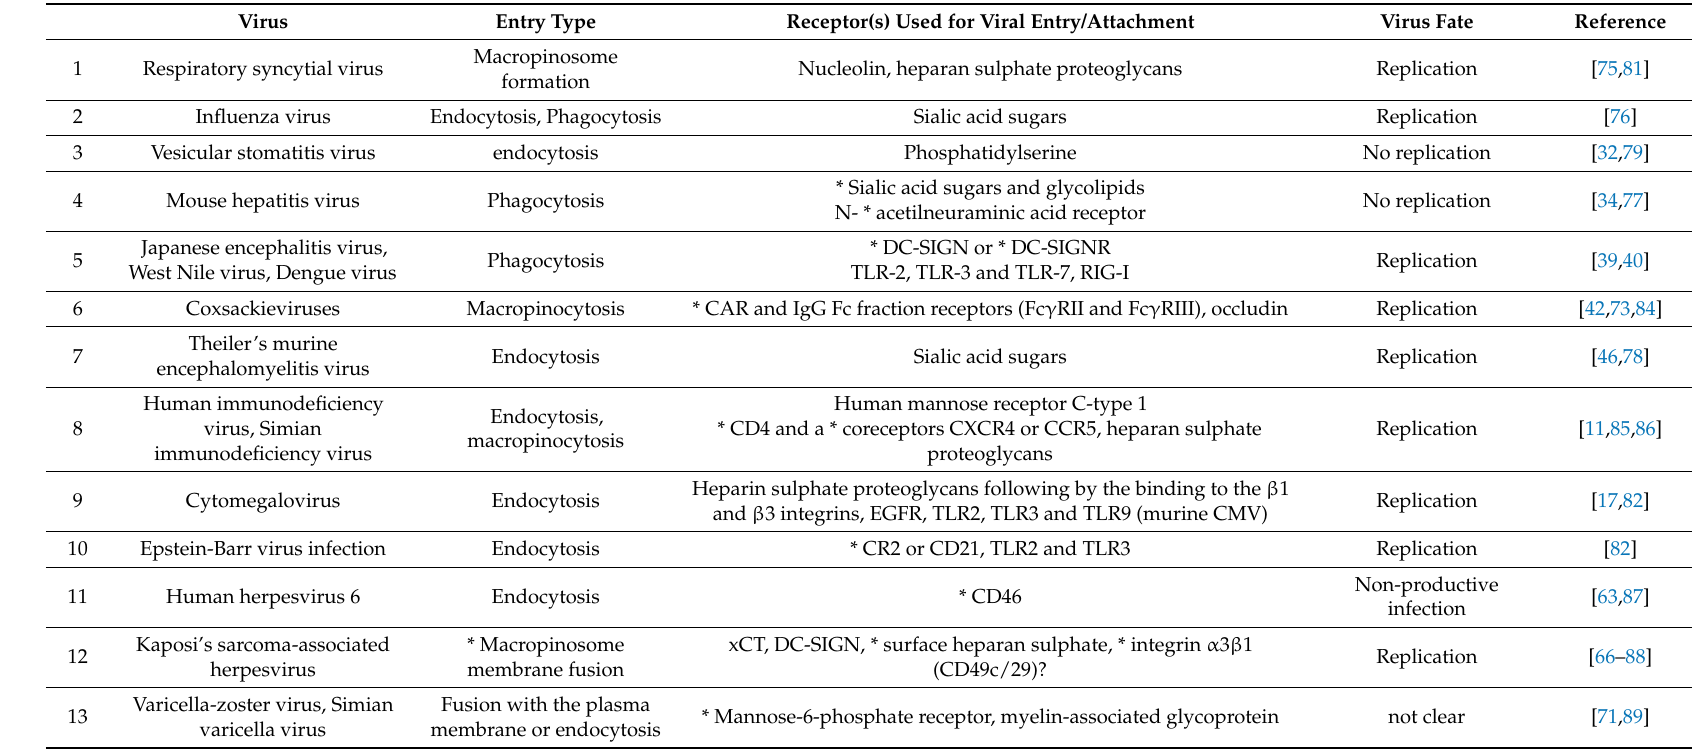
Table 2. Virus-host cell